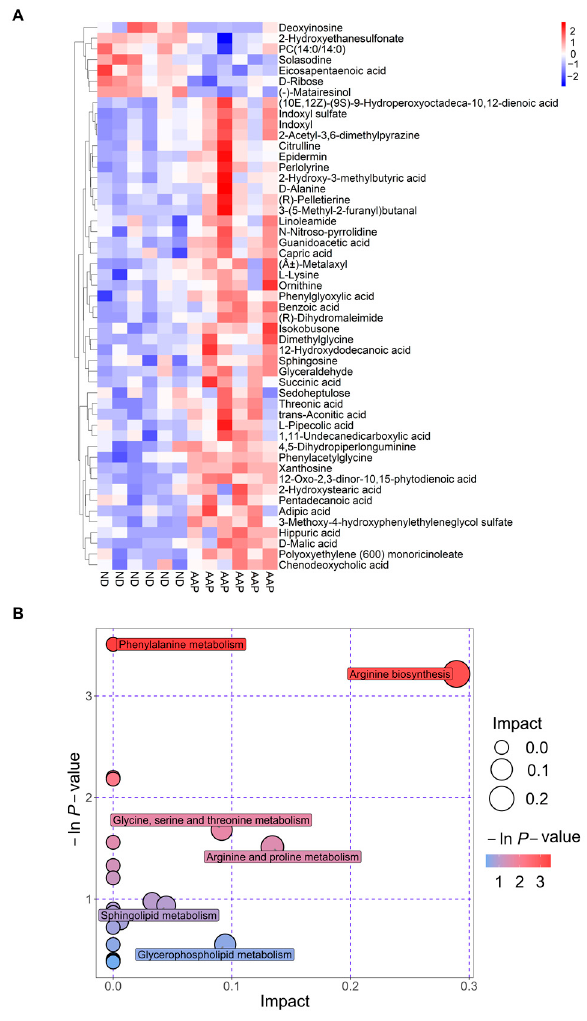
Figure 4. Metabolic pathway analysis. ( A ) Thermogram of serum biomarker changes; ( B ) Bubble chart. ND = normal diets; AAP = Auricularia auricula polysaccharides.